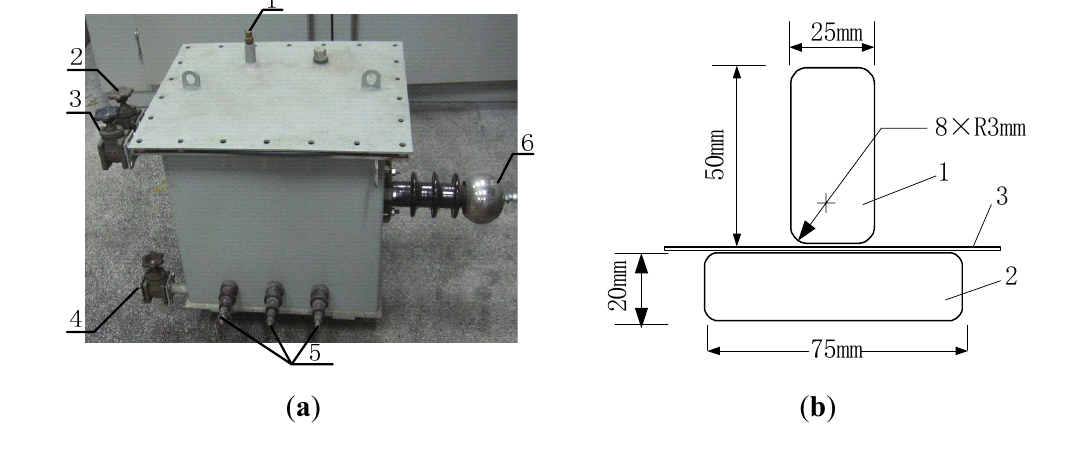
Figure 2. ( a ) The oil tank for electro-thermal aging test; ( b ) Schematic diagram of the experimental electrode. (1) tee valve; (2) air valve; (3) oil inlet valve; (4) oil outlet